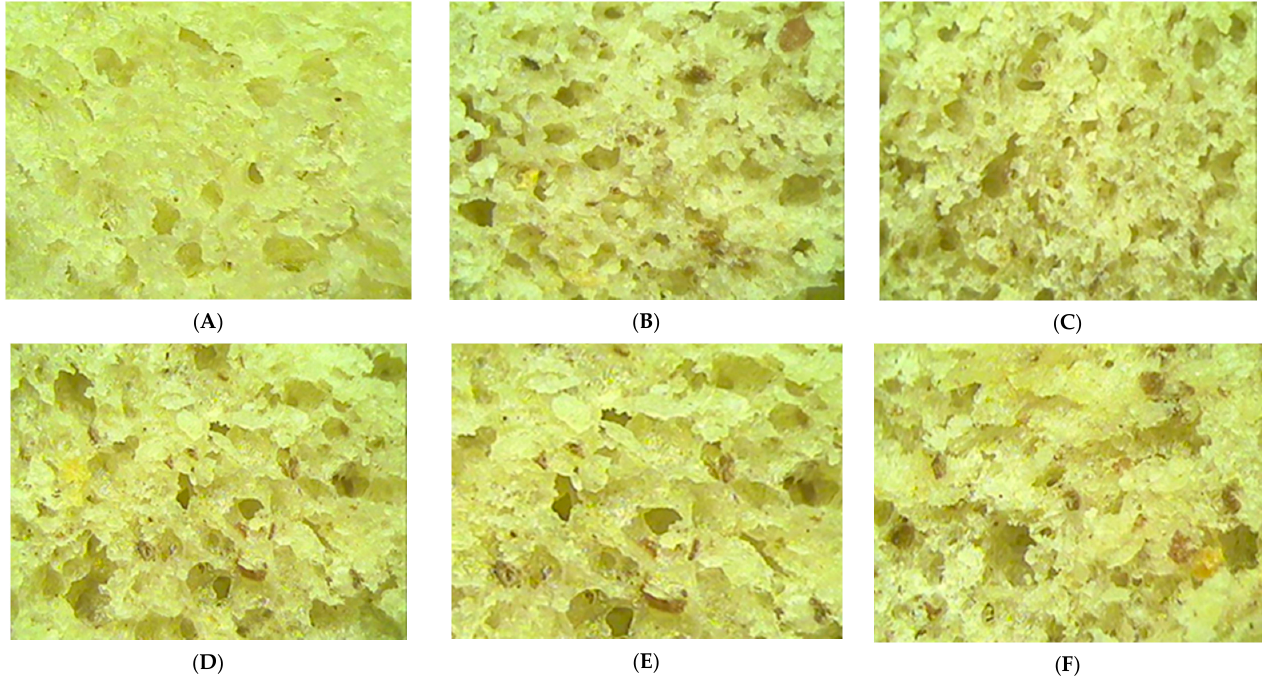
Figure 4. Microstructure of the crumb samples with germinated bean flour (GBF) at different levels: 0% ( A ), 5% ( B ), 10% ( C ), 15% ( D ), 20% ( E ) and 25% ( F ).